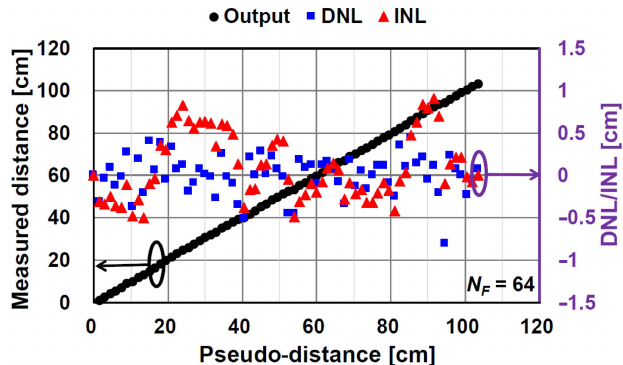
Figure 15. Measurement results of measured distance, differential nonlinearity (DNL), and integral nonlinearity (INL) of prototype chip ( N F = 64).